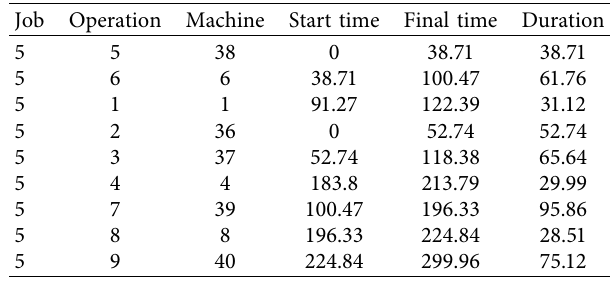
Table 16: Sequence of job 4 operations.